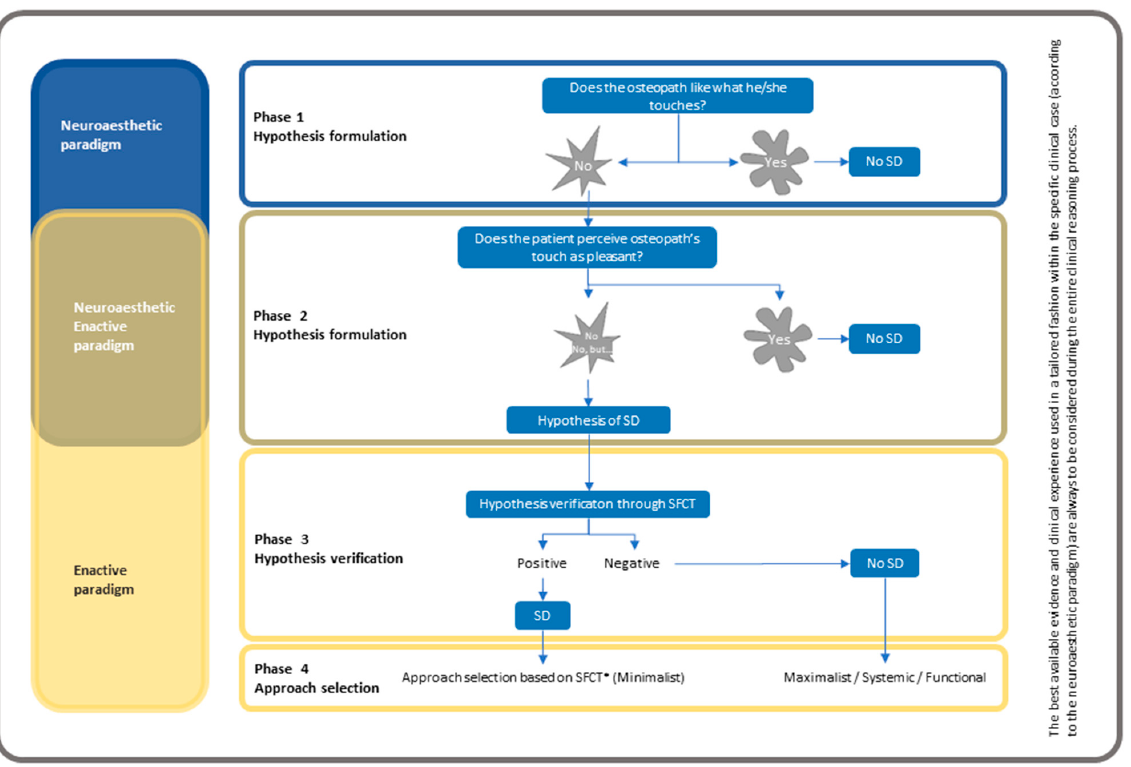
Figure 4. SFCT algorithm: hypothesis formulation, validation phases and approach selection.